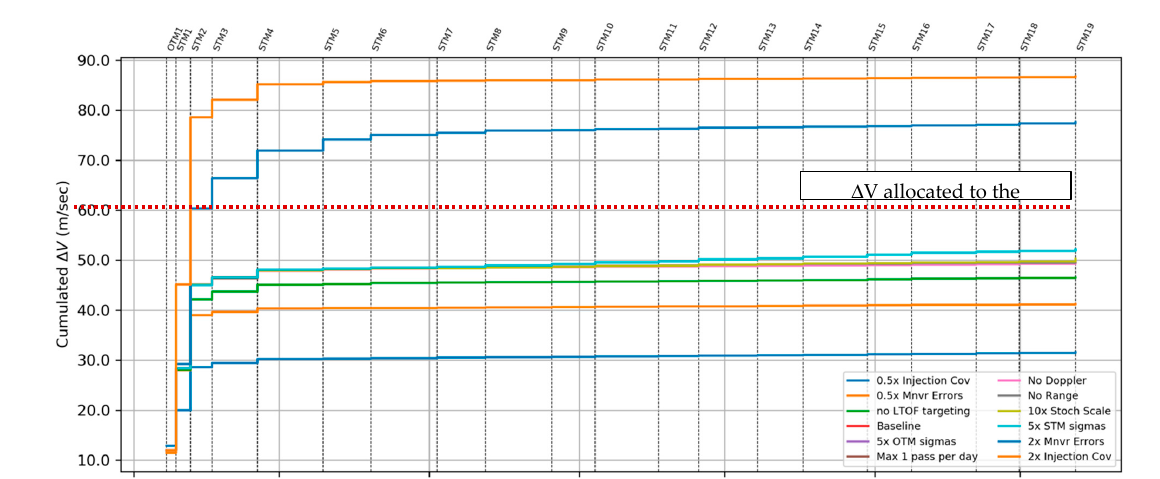
Figure 16. Full mission cumulated Δ V statistics plot for each FPC relevant sensitivity case.